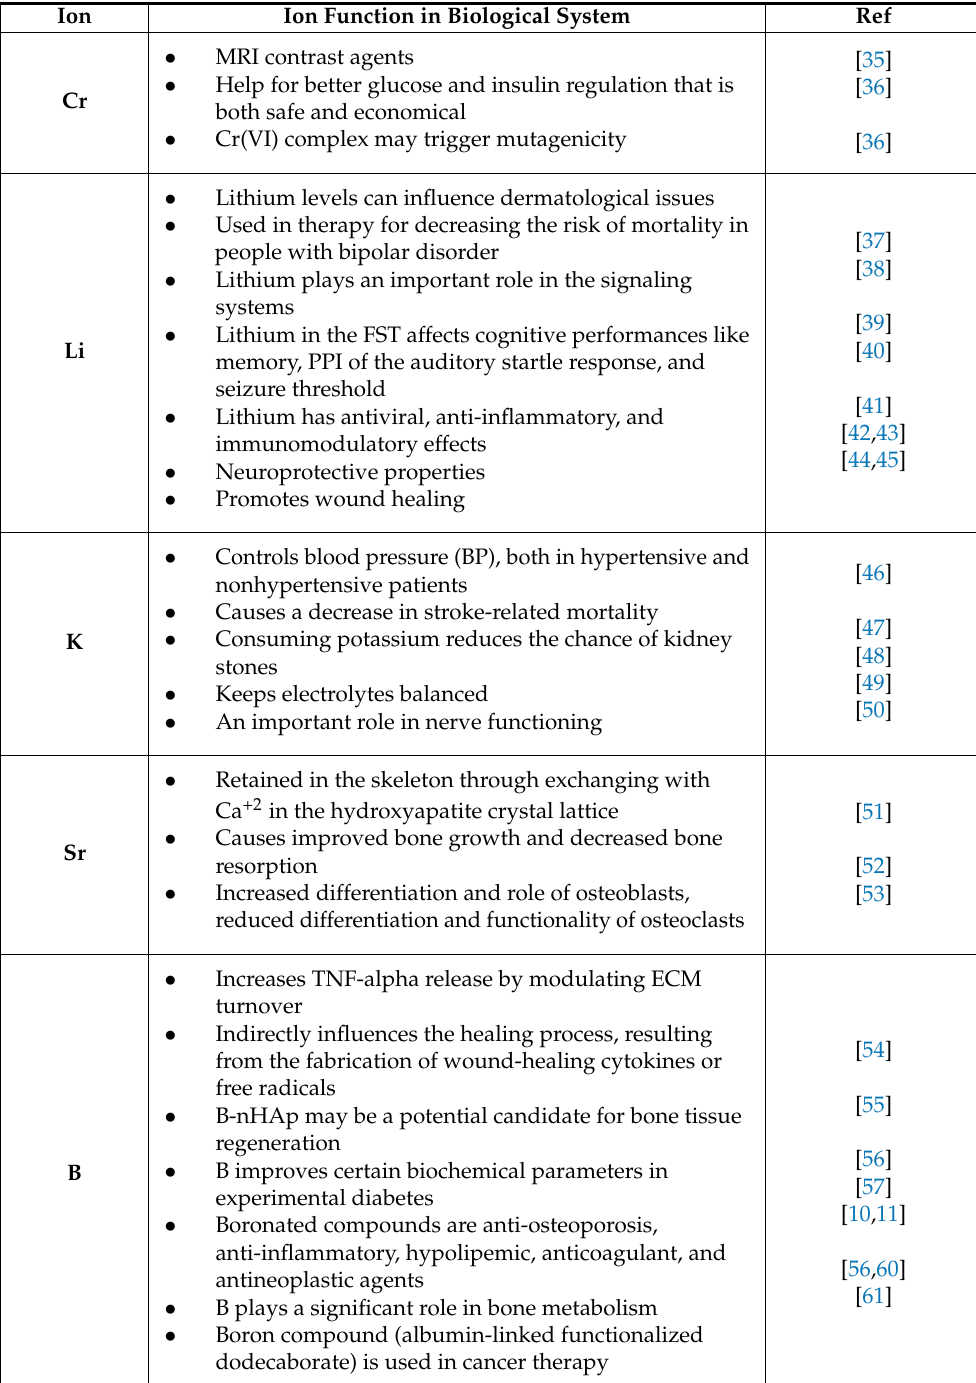
Table 2. Cont. Ion Ion Function in Biological